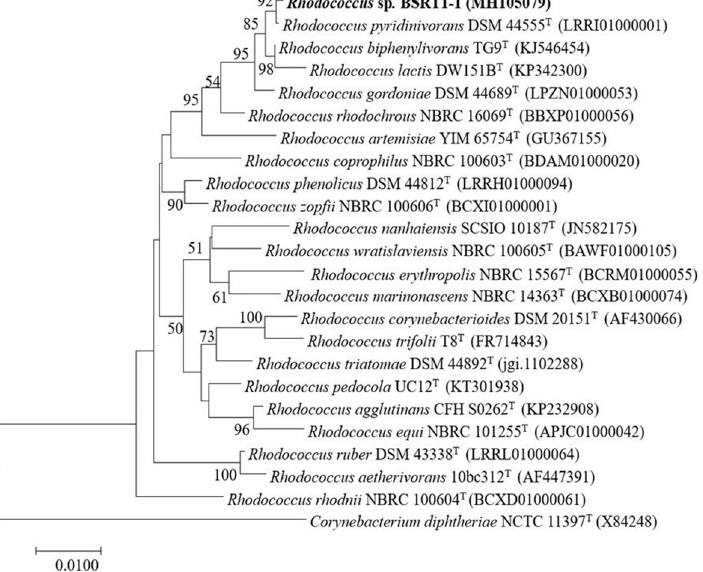
Figure 1. Neighbor-joining tree, based on 16S rRNA gene sequences, showing the position of BSRT1-1 and closely related species of Rhodococcus . Numbers at nodes indicate levels of bootstrap support (%) based on neighbor-joining analysis of 1000 resampled datasets; only values ≥ 50% are given. Filled circles indicate branches of the tree that were also recovered using the maximum-parsimony and maximum-likelihood tree- making algorithms. Corynebacterium diphtheriae NCTC 11397 T (GenBank Accession No. X84248) was used as an outgroup. Bar, 0.01 substitutions per